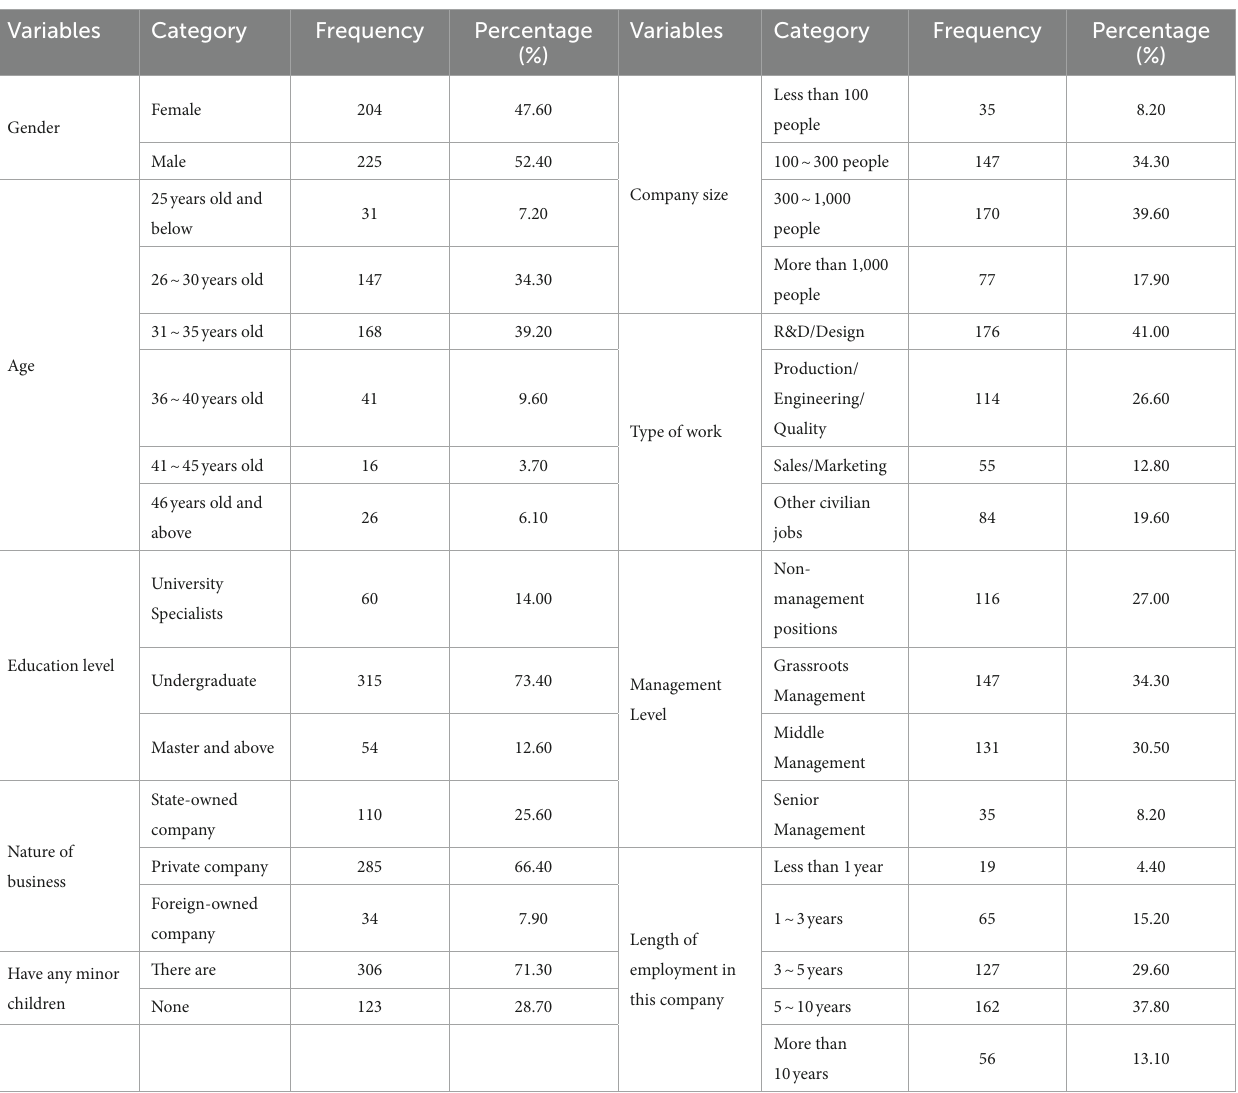
TABLE 1 Basic information of the samples ( N =